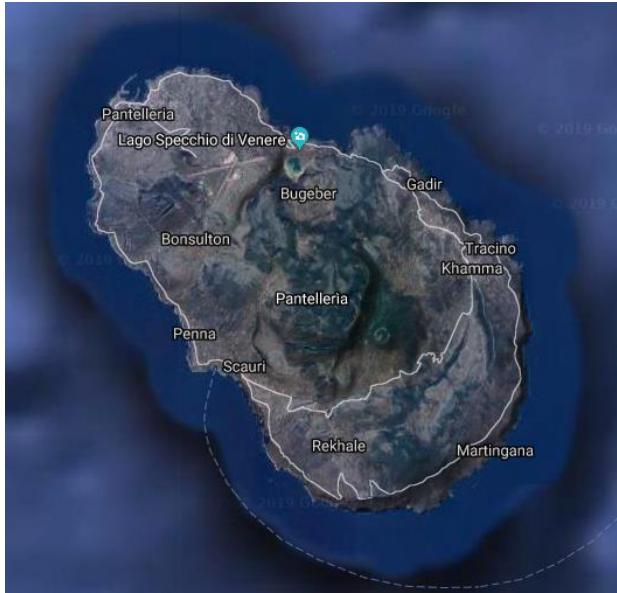
Figure 2. Satellite view of Pantelleria [75].